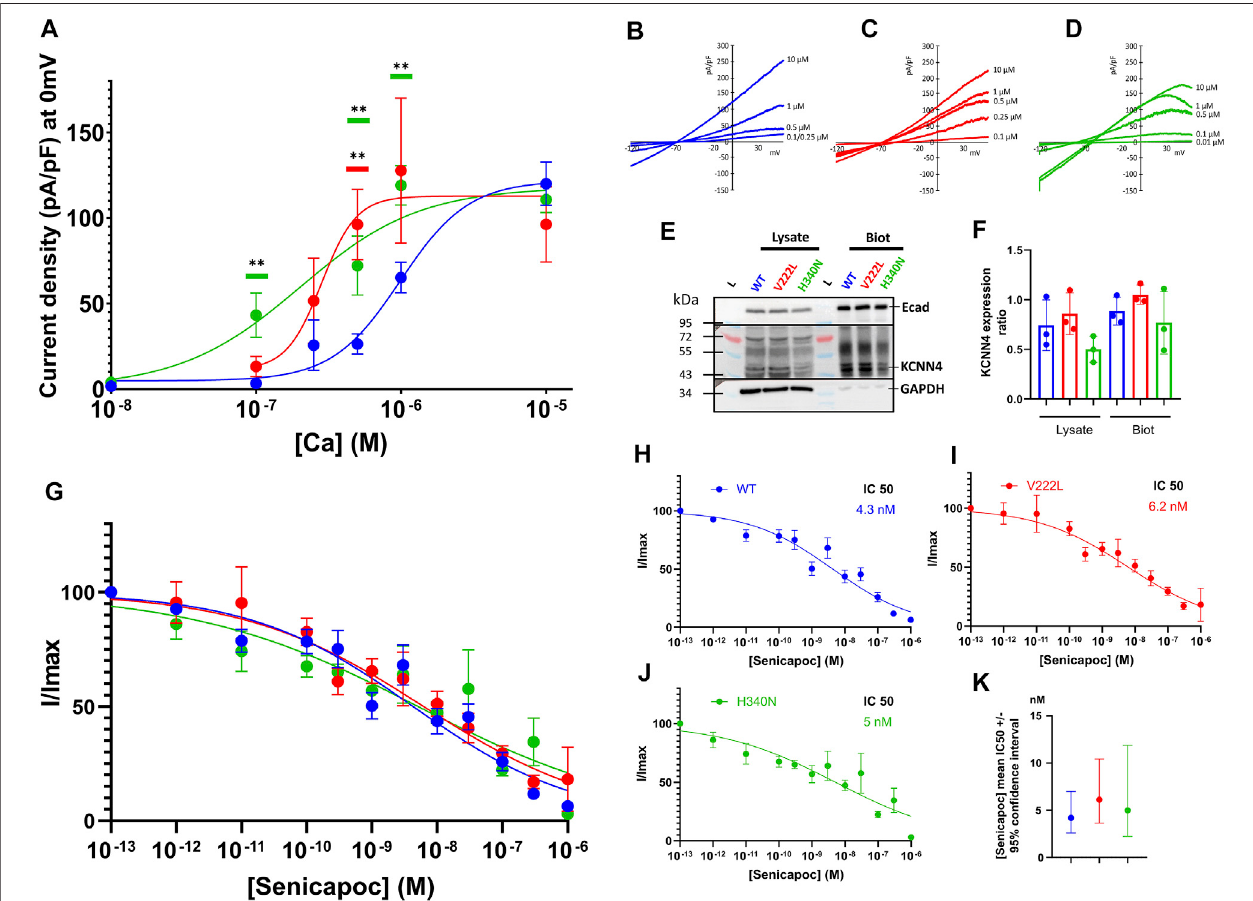
FIGURE 4 | Calcium sensitivity of KCNN4 mutations V222L and H340N in HEK293T cells. (A) Current density (pA/pF) was measured in response to (Ca 2+ ) i for KCNN4WT(blue),V222L(red), andH340N(green).Experimentalvalueswere fi ttedwithavariableslopemodel(Hillequation)(Y=Y min +(X hillslope )*(Y max -Y min )/(X hillslope + EC50 Hillslope ). The resulting EC50 corresponds to the (Ca 2+ ) i at which half of the max current is reached. (B – D) Representative I/V curves for WT, V222L, and H340N at different Ca 2+ concentrations (0.01 – 0.1 – 0.25 – 0.5 – 1, and 10 µM). Statistical analysis against WT at different Ca 2+ concentrations was performed using a Kruskal – WallistestfollowedbyanuncorrectedDunn ’ stest, n =7 – 12(*: p < 0.05;**: p < 0.01). (E) Representativewesternblotshowingtotal(Lysate)oronlysurface(Biot) proteinexpressionofKCNN4WT,V222L,andH340NinHEK293T-transfectedcells.Totalfractioncorrespondedtocelllysateandbiotinylatedfractioncorrespondedto membrane proteins. We used GAPDH ashousekeepingfor totalfraction quanti fi cation (lysate) and E-cadherin forbiotinylatedfraction quanti fi cation. In KCNN4 labeling, thethreebandsbetween43 kDaand55 kDacorrespondedtodifferentglycosylatedstatesoftheprotein.Inlysate,thebandat72 kDaisnon-speci fi c. (F) RatioKCNN4/ GAPDH in lysate and KCNN4/ECadherin (biotinylation) were calculated from three independentWestern Blots, taking the total KCNN4 signal. No signi fi cantly increased expression with V222L and H340N compared to WT KCNN4 was observed. Only H340N tended to have a reduced expression. Kruskal – Wallis test was used to determinestatisticalsigni fi canceagainstWT. (G) SenicapocsensitivityofKCNN4WTormutated.Normalizedcurrentsweremeasuredinresponseto[Senicapoc]forWT (blue), V222L (red), and H340N (green). Experimental values were fi tted with variable slope model (Hill equation): Y = 100/(1 + (IC50/X) hillslope ). The resulting IC50 corresponded to 50% inhibition by Senicapoc; the mean value ±95% con fi dence interval of IC50 is represented in (K) , n = 15 – 21. For clarity purposes, fi ts are represented alone for each condition (H,I,J) . Statistical analyses were performed using a Kruskal – Wallis test followed by an uncorrected Dunn ’ s test, n = 15 –